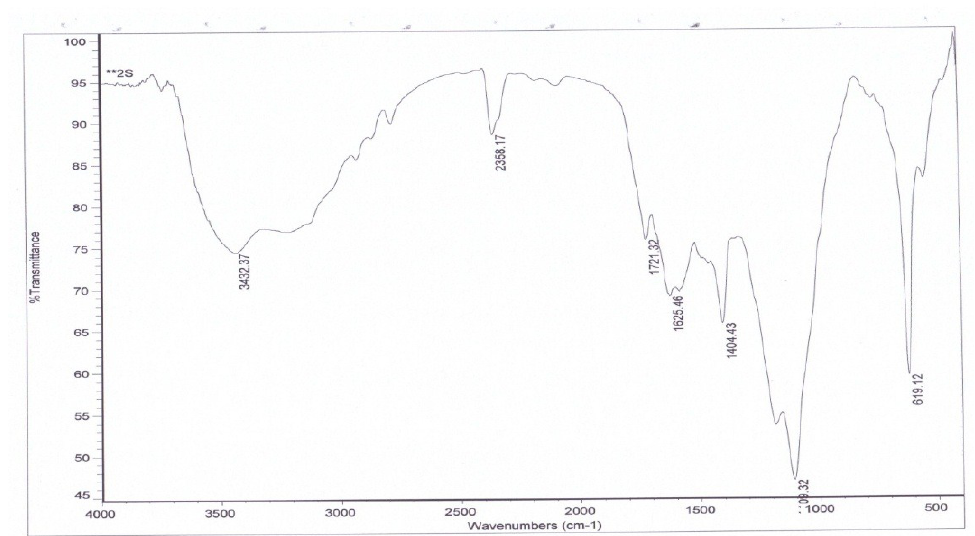
Figure 1B . FTIR spectrum of polyreactive blue